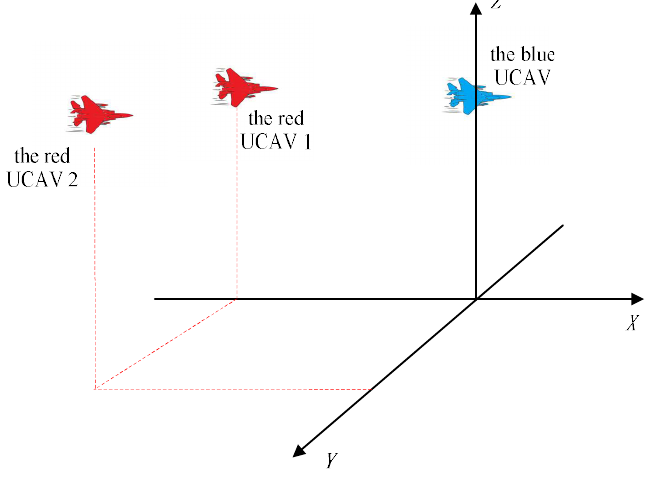
Figure 5. Initial position setting.